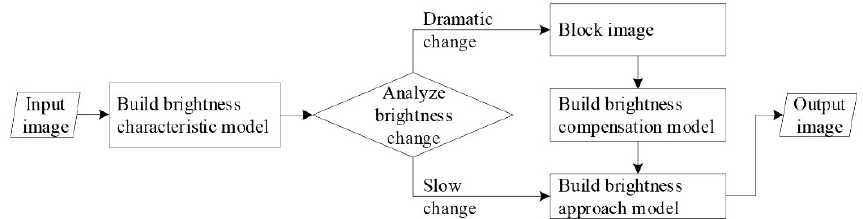
Figure 1. Flowchart of the proposed method.